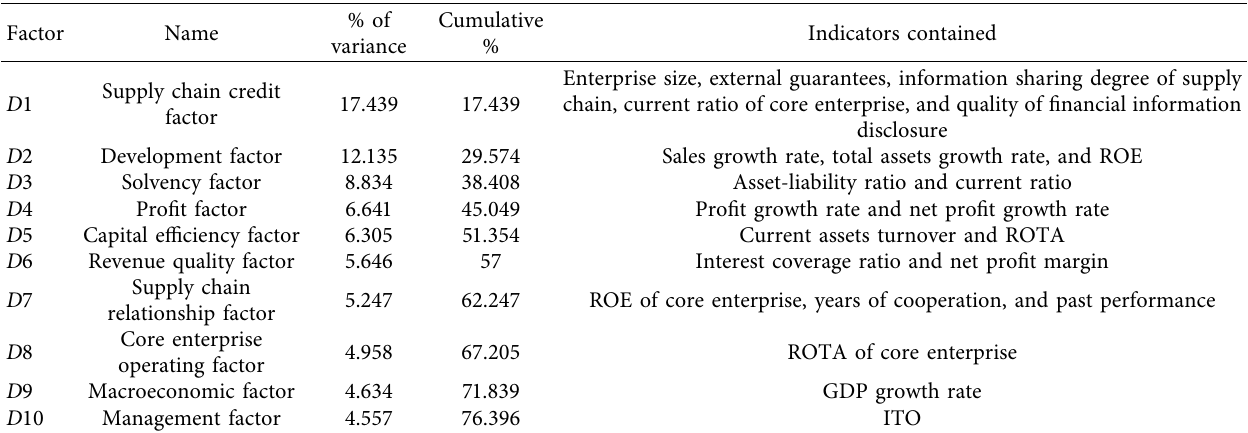
Table 8: Factor explanation table (construction